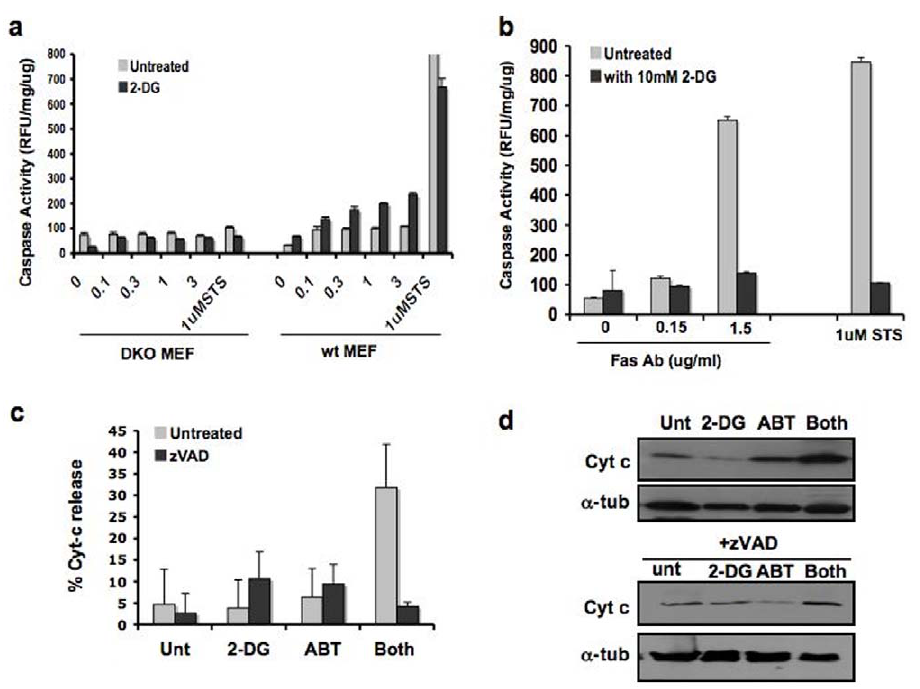
Figure 3. 2DG-ABT induced apoptosis is a non-canonical mitochondria-dependent form of apoptosis. a, Wt, and Bax/Bak DKO MEFs were treated with 10 mM 2DG for 3 hours before the addition of 3 m M ABT-263 for 3 hours. 3 hours later, cells were harvested for caspase activity assays. (See also Fig. S5a). b, HT1080 cells were treated with or without 2DG for 3 hours. Then cells were treated with either 1 m M STS or anti-Fas (CD95) antibody at indicated concentrations ( m g/ml). Cells were harvested 3 hours after, and assayed for caspase activity. Interestingly, 2DG seems to have interfered with Fas-induced apoptosis. In repeated experiments, we observed consistently lower rates of caspase activation in 2DG pre-treated cells, but the degrees of inhibitory activity varied from experiment to experiment. We are not sure of its cause. c, For the first 3 hours, HeLa cells were either treated with 10 mM 2DG or left untreated and then treated with 10 m M z-VAD, 1 m M ABT-737, both, or neither for 3 more hours. The cells were fixed and stained for DNA (red) and cytochrome c (green) and examined for loss of cytochrome c staining, as described in Methods. Bar indicates 100 m m. The representative images are shown in Fig. S3. This graph shows the percentage of cells with loss of cytochrome c staining. The combination treatment had higher rates of cells with released cytochrome c (p=0.008 by unpaired t-test ). d, Cells treated as in c were fractionated and cytosolic fractions were analyzed by western blots.